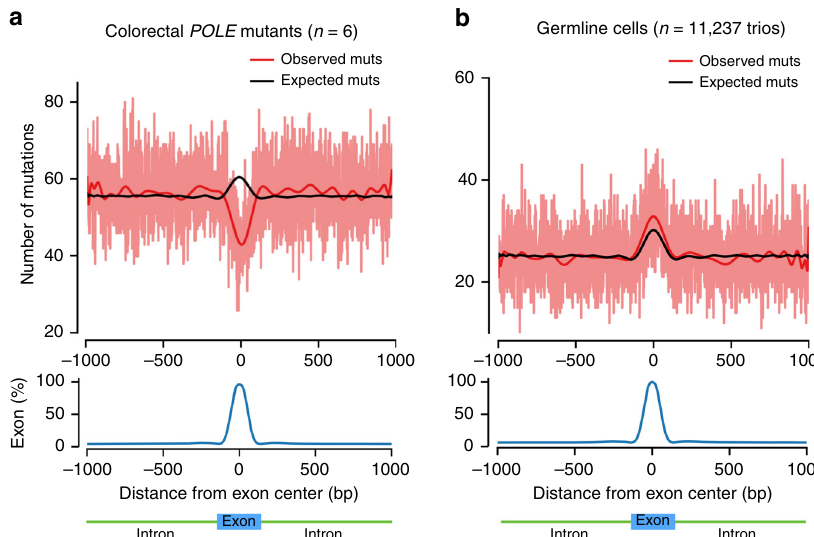
Fig. 1 Internal exon-centered analyses on somatic and germline de novo mutations. Exon-centered 2001-nt-wide observed and expected mutational pro fi les (top) and exon density (bottom) in a somatic and b germline cells. The light red line represents the observed number of mutations at each position, whereas the dark red and black lines represent smoothed numbers of observed and expected mutations, respectively, obtained from a polynomial fi t. a Pro fi le of mutations in six POLE -mutant colorectal tumors, reprinted by permission from Springer Nature Customer Service Centre GmbH: Springer Nature Genetics, Reduced mutation rate in exons due to differential mismatch repair, Frigola et al. 17 . b Pro fi le of mutations in the germline of 11,237